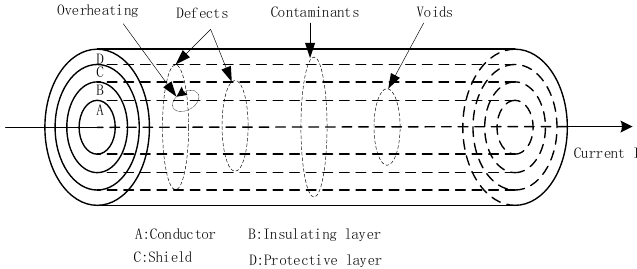
Figure 4. Schematic diagram of eddy current when the power cable is abnormal.